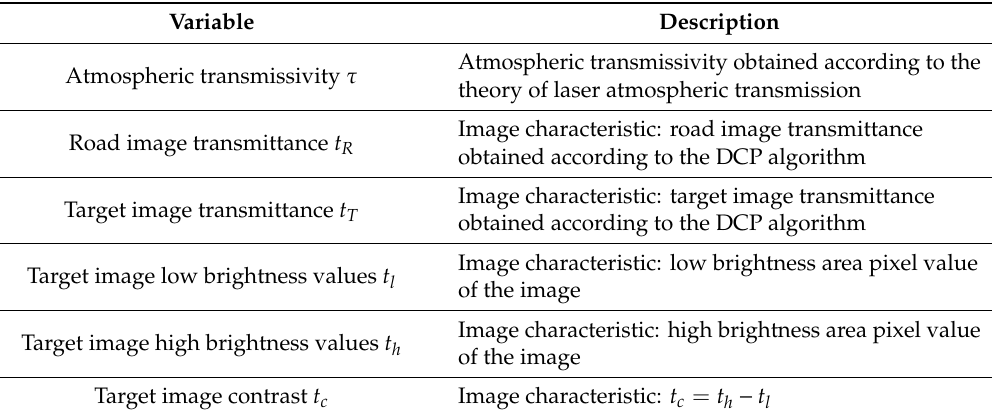
Table 1. List of variables describing visibility.